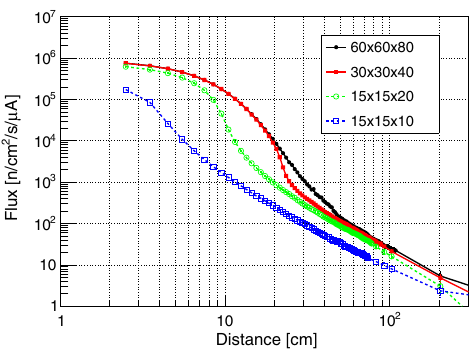
Figure 2: Thermal neutron flux (E n < 400 meV) as a func-